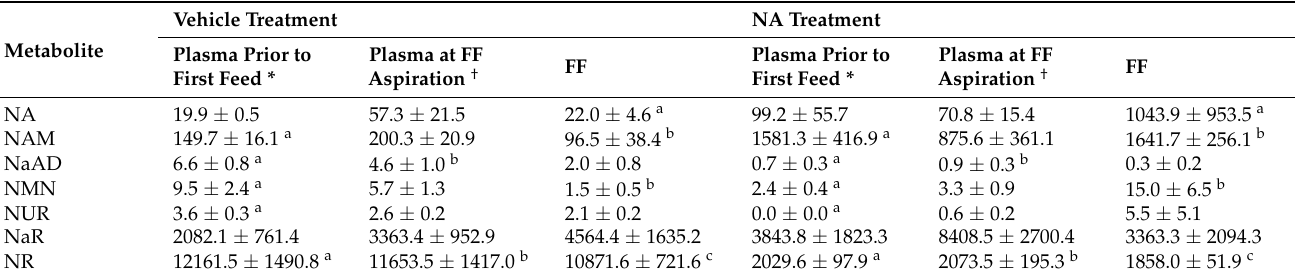
Table 1. The concentrations (ng/ µ L) of NAD + precursors in the plasma and follicular fluid (FF) of mares fed the vehicle and nicotinic acid (NA) treatments. Values are presented as the means ± sem. Within each row, values labelled with the same superscript letter are significantly